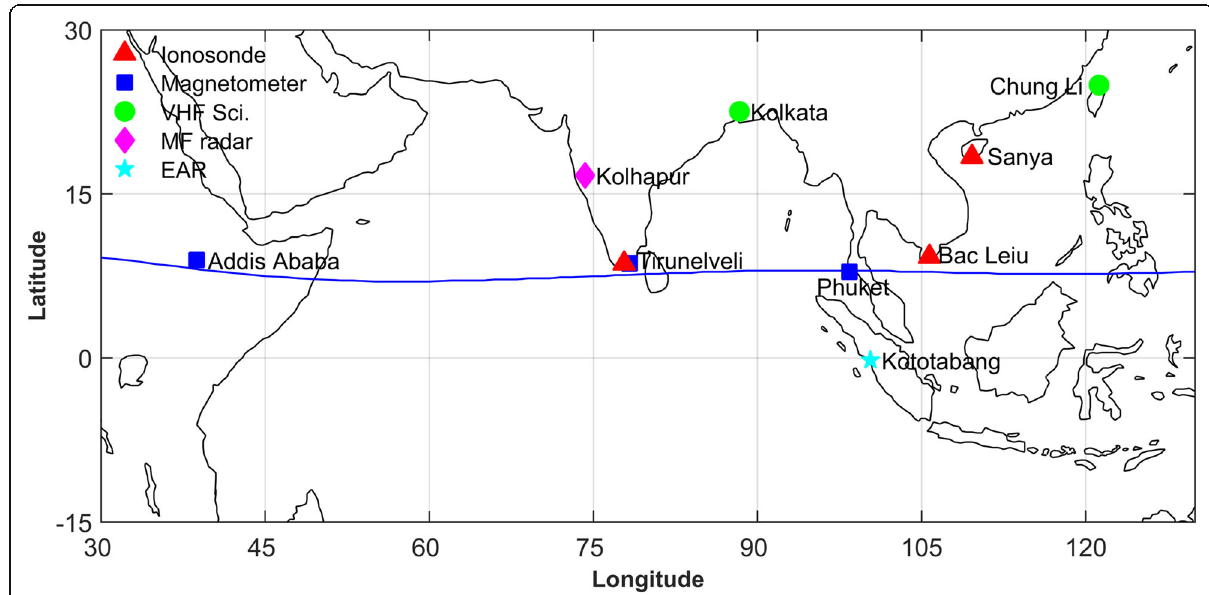
Fig. 1 The geographic locations of different instruments used in the present study. The blue line indicates the geomagnetic